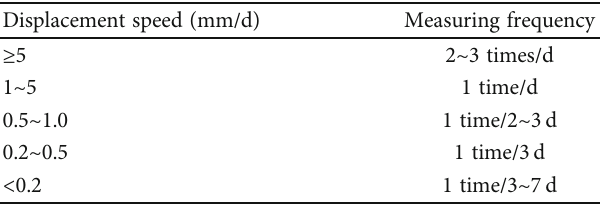
Table 3: Measuring frequency of dome subsidence and peripheral convergence displacement (displacement according to velocity).